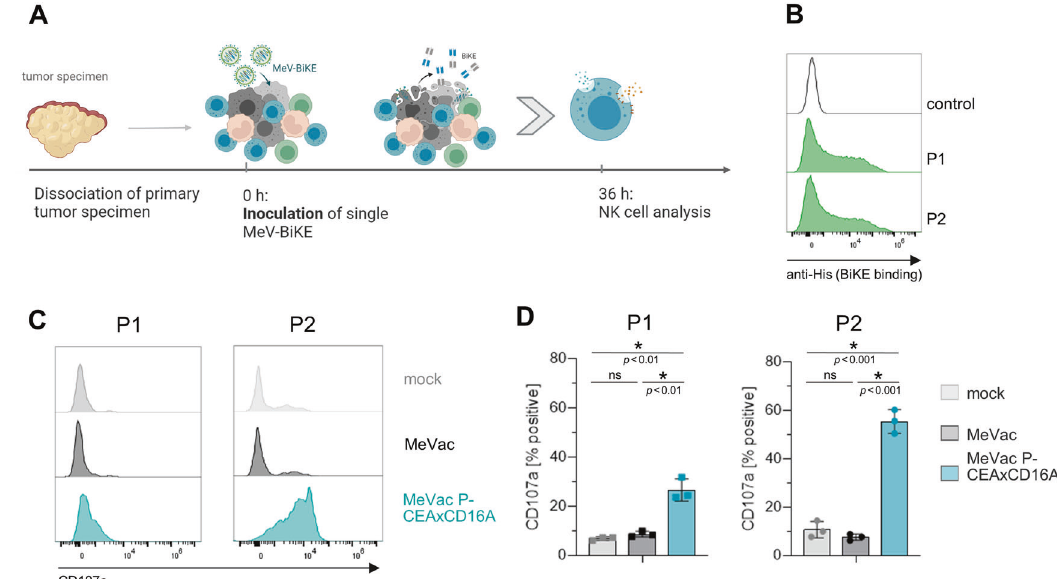
Fig. 6 MV-BiKE activity in primary colorectal cancer. NK cell degranulation was analyzed after infection of single cell suspensions of patient- derived colorectal carcinoma specimens. MV-BiKE infections were compared to MV infection and mock controls. A Schematic outline of ex vivo experiments. B BiKE binding to single cell suspensions of patient-derived colorectal carcinoma. Cell suspensions were incubated with CEAxCD16A vBiKEs. Binding was assessed via fl ow cytometry (gated on all viable cells) based on BiKE labeling with anti-His 6 antibodies. Histograms for patient 1 (P1) and patient 2 (P2) are depicted. C , D NK cell granulation upon MV-BiKE treatment. Colorectal carcinoma single cell suspensions were infected and NK cell degranulation was analyzed by fl ow cytometry. C NK cell degranulation (CD107a) in response